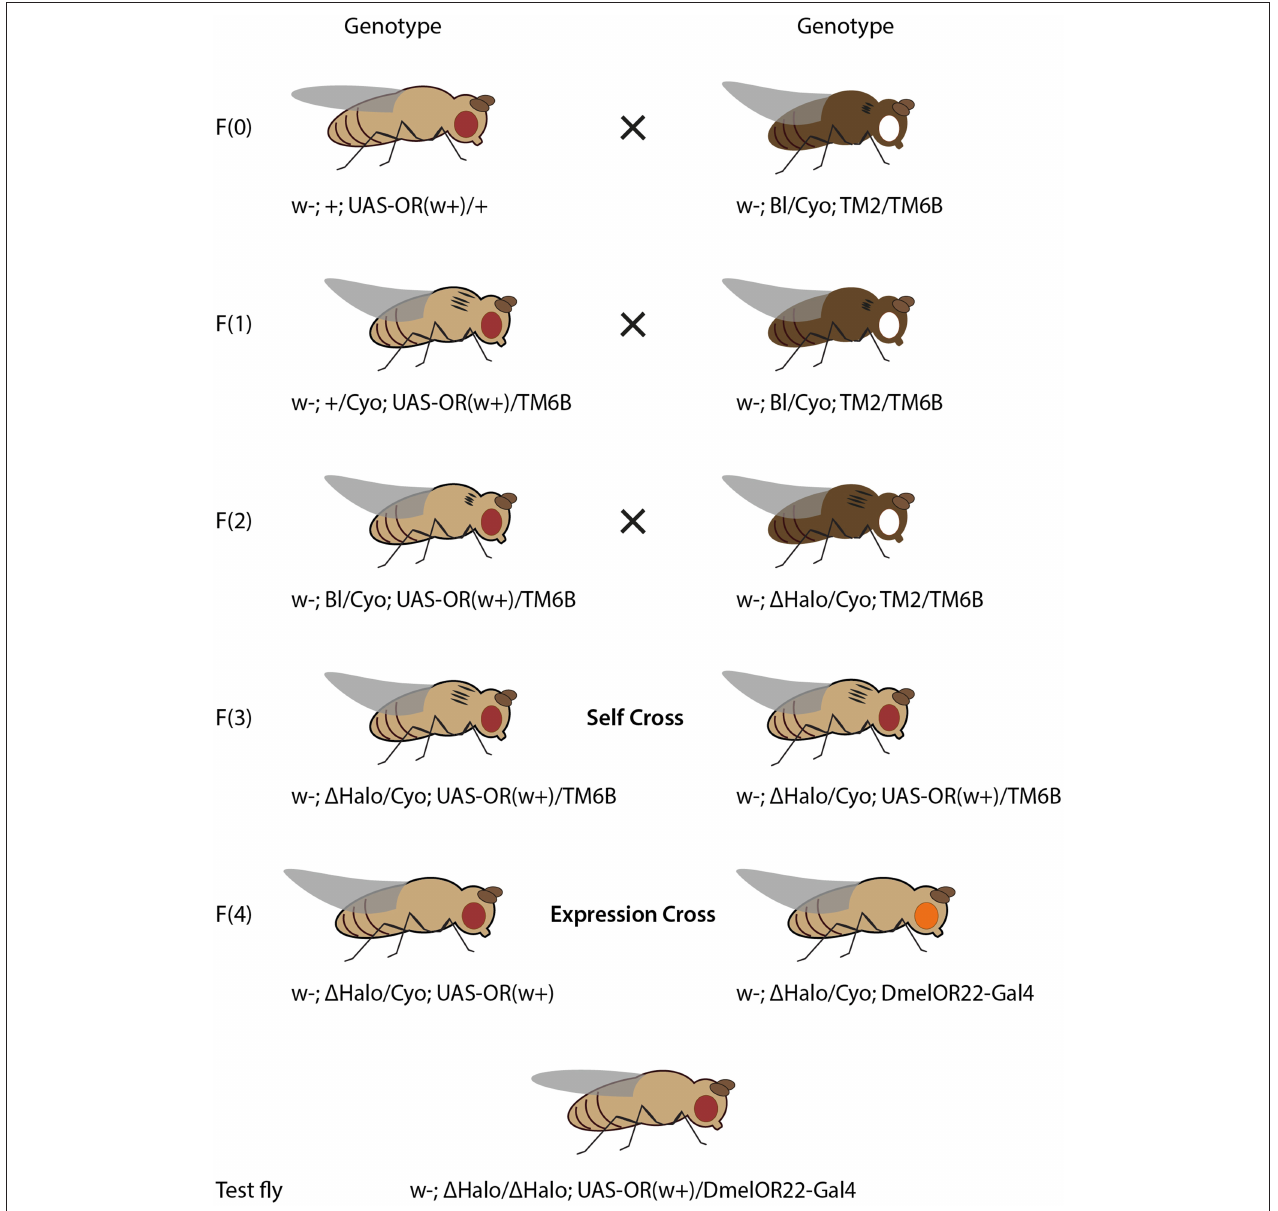
FIGURE 2 | Crossing scheme for heterologous expression of an OR transgene in empty neurons in ab3 sensilla, using 1 Halo mutant background and DmelOR22a-Gal4 driver line. Fly drawing by Katarina Eriksson